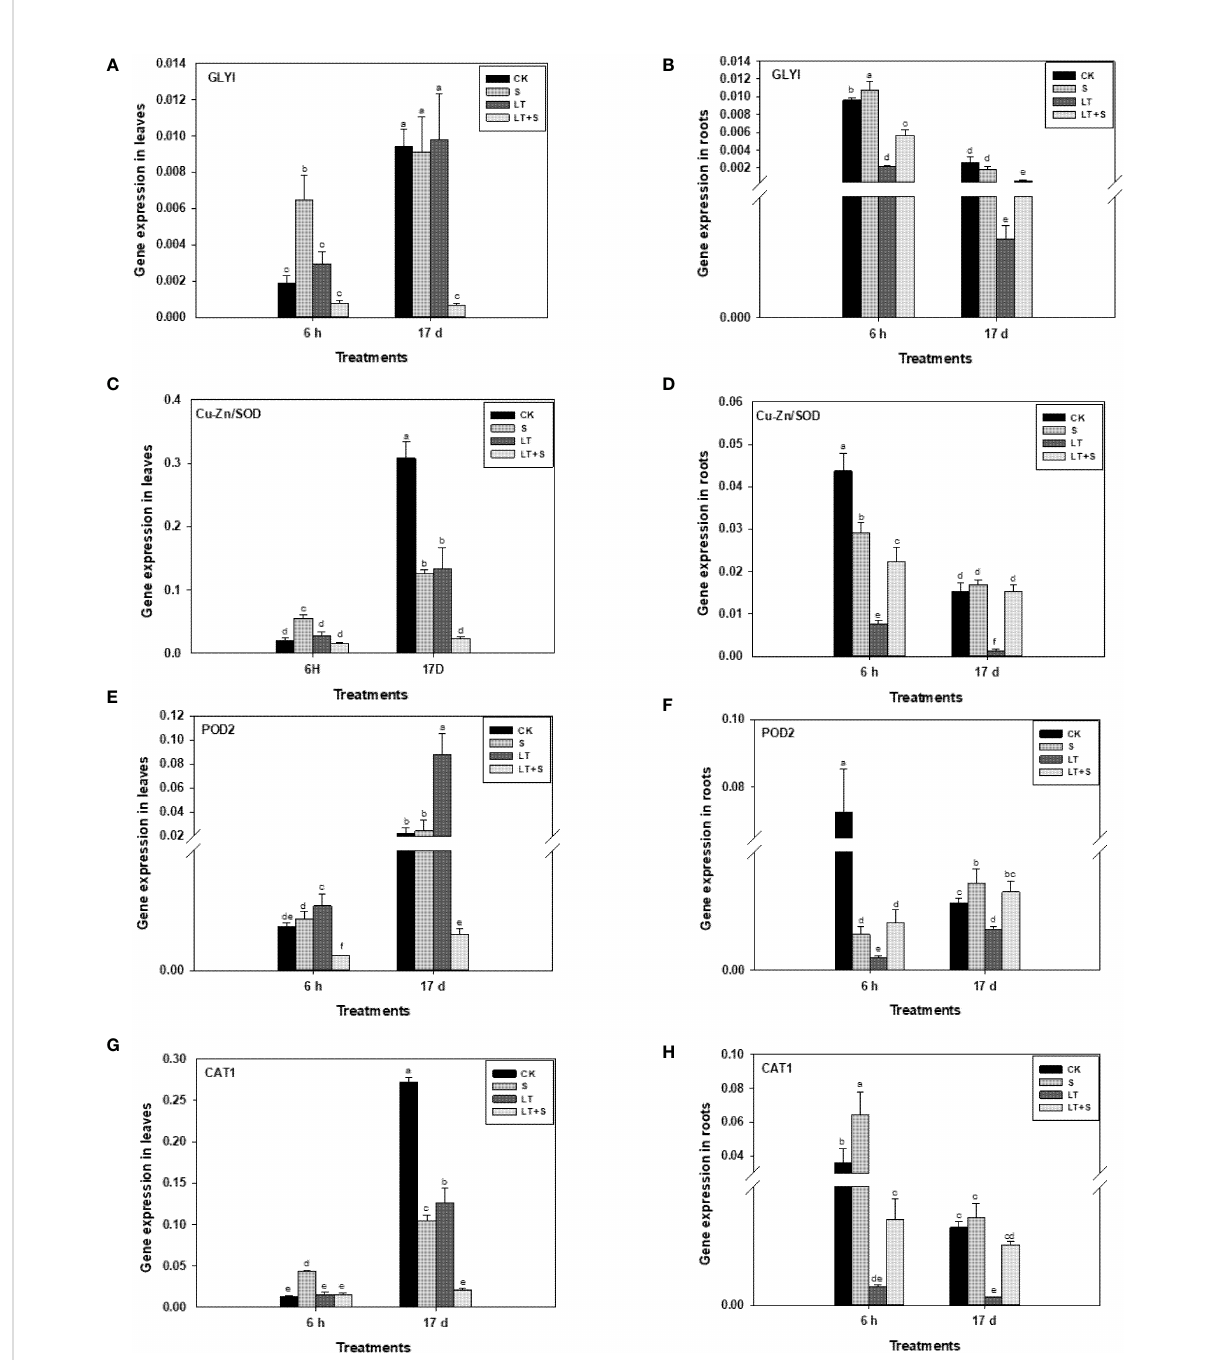
FIGURE 4 Glyoxalase and antioxidant enzyme related genes transcriptional level in bermudagrass under low temperature and salt stress. (A, C, E, G) represents genes transcriptional level in leaves and Figure (B, D, F – H) represents genes transcriptional level in roots. Different letters above the same columns indicate statistic signi fi cant difference at P < 0.05 (Duncan ’ s multiple range